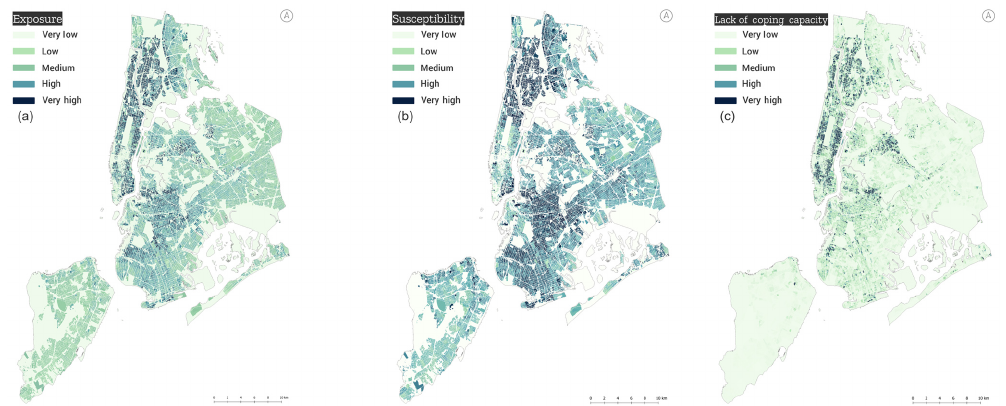
Figure 4. Spatial variation in three components of vulnerability ( a : exposure, b : susceptibility and c : lack of coping capacity) to multiple hazards.